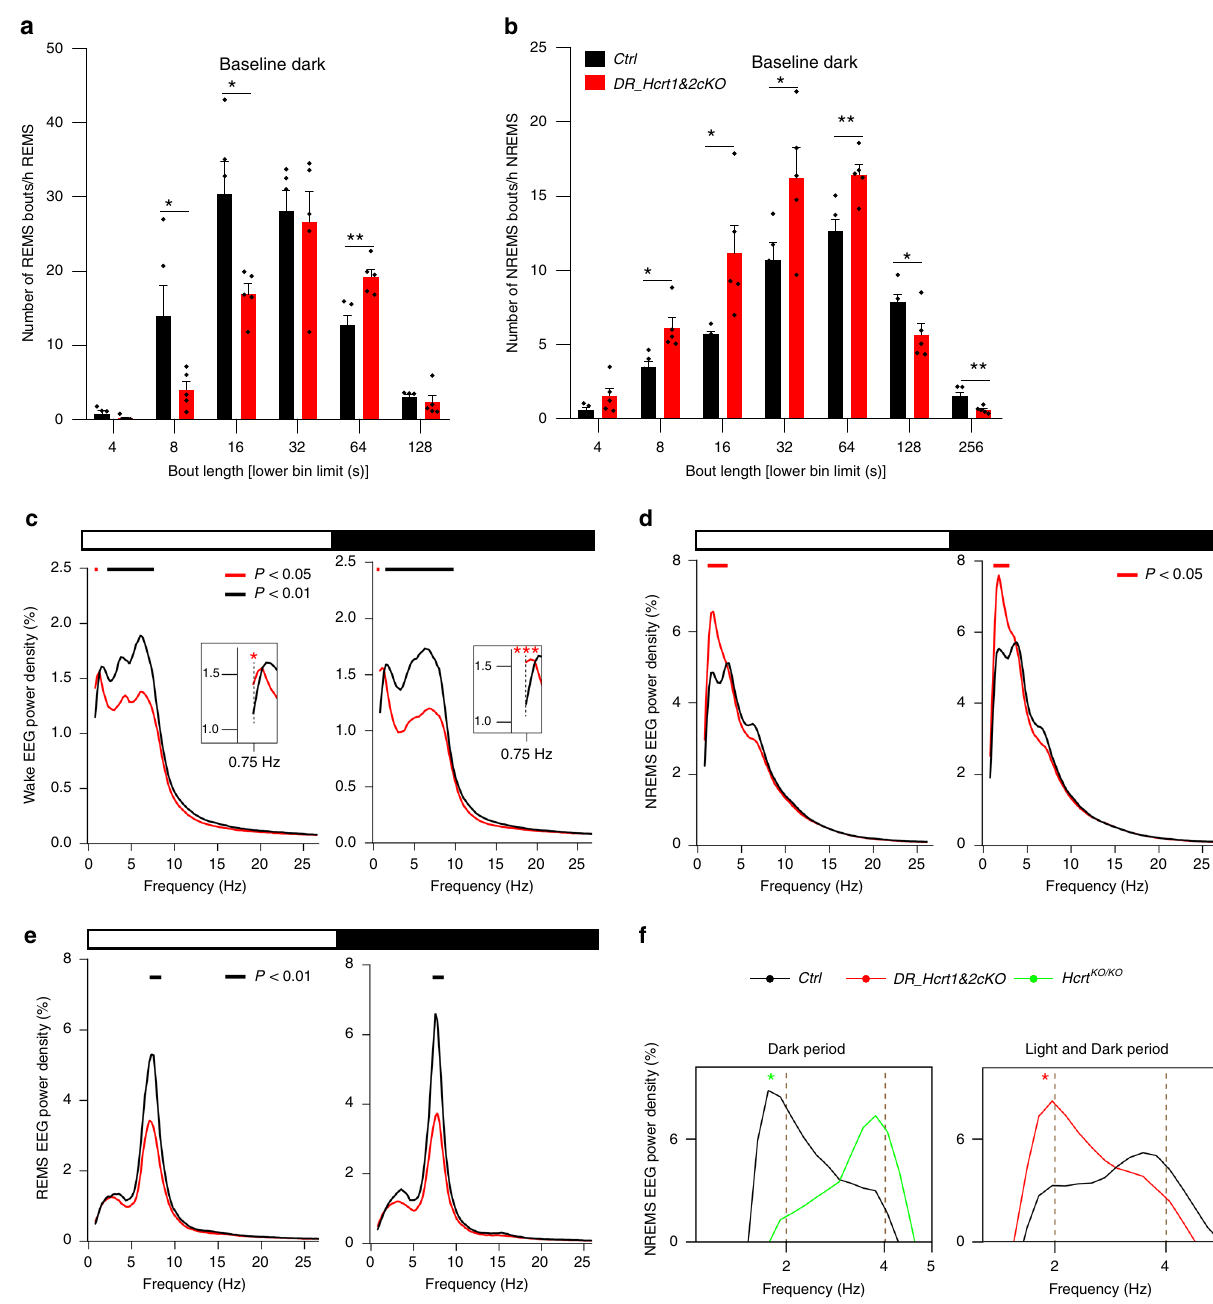
Fig. 5 Profound alterations in vigilance states quality in DR Hcrtr1 & 2 gene-inactivated mice. a Distribution in REMS bout durations during the dark period. Lower numbers in each bout duration bin are presented on the x axis. REMS is markedly consolidated in DR_Hcrtr1&2-cKO mice (unpaired 2-tailed t - test, t (8) = 2.27 for 8 s, P = 0.05), 2.88 for 16 s, P < 0.05, and 3.87 for 64 s, P < 0.01, mean ± SEM). b Distribution of NREM bout durations during the dark period. NREMS is highly fragmented in DR_Hcrtr1&2-cKO mice (unpaired two-tailed t -test, t (8) = 3.25 for 8 s, P < 0.05, 2.86 for 16 s, P < 0.05), 2.36 for 32 s, P < 0.05, 3.61 for 64 s, P < 0.01, 2.41 for 128 s, P < 0.05) and 3.39 for 256 s, P < 0.01, mean ± SEM). c Baseline waking EEG power spectra during light (left) and dark (right) periods. Data are normalized to the total EEG power during baseline. Insets show higher magni fi cation of lower frequencies (two-way ANOVA, interaction frequency × genotype F (196, 1568) = 3.86 (light), 5.7 (dark), P < 0.0001, followed by Dunnett ’ s test, horizontal bars join frequency bins for which P < 0.05). d Baseline EEG power spectra for NREMS (two-way ANOVA, interaction frequency × genotype F (196, 1568) = 2.26 (light), 1.81 (dark), P < 0.0001, followed by Dunnett ’ s test, P < 0.05). e Baseline EEG power spectra for REMS (two-way ANOVA, interaction frequency × genotype